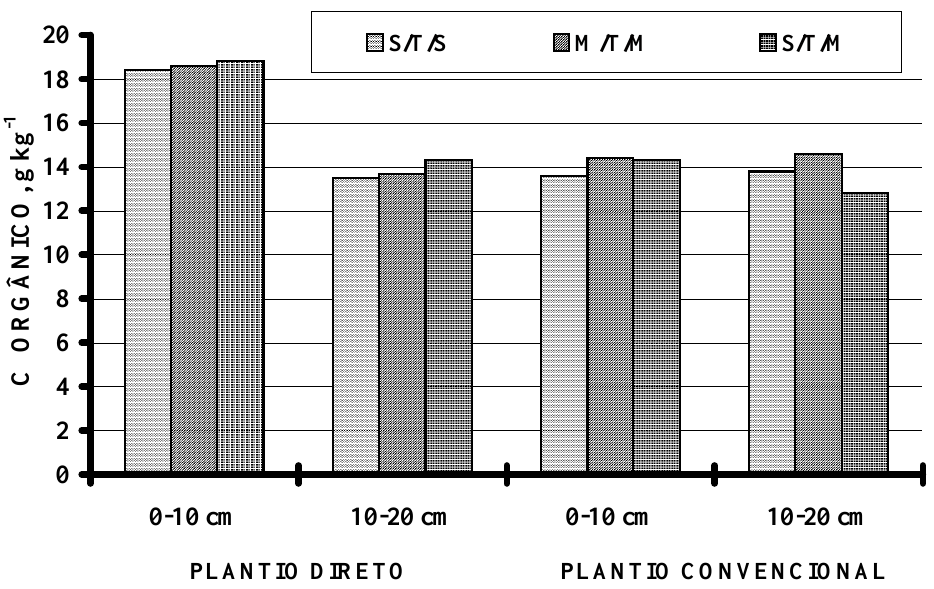
Figura 1. Teores de carbono orgânico em dois sistemas de plantio e três rotações de culturas em duas profundidades do